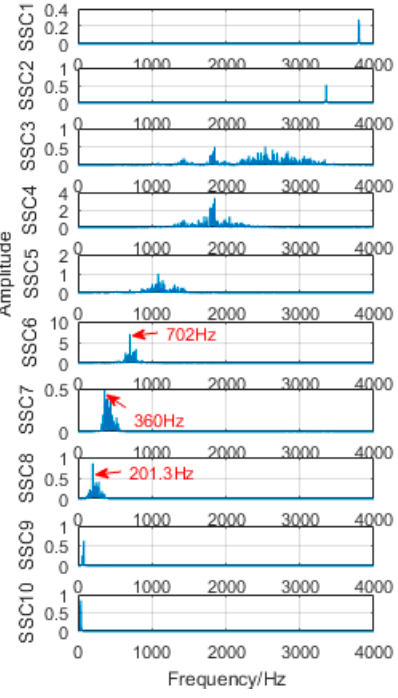
Figure 29. Frequency domain diagram of decomposition results obtained by SSD.